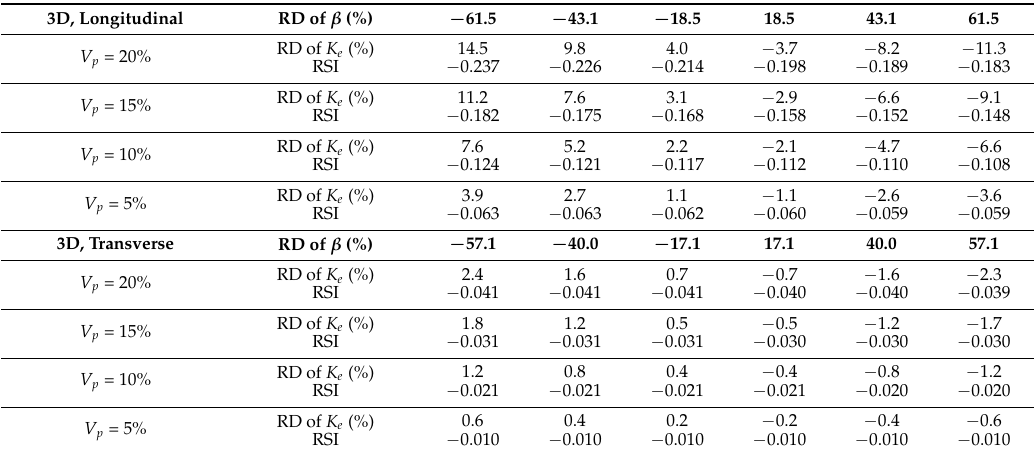
Table 5. Sensitivity analysis of the pore shape factor for 3D braided